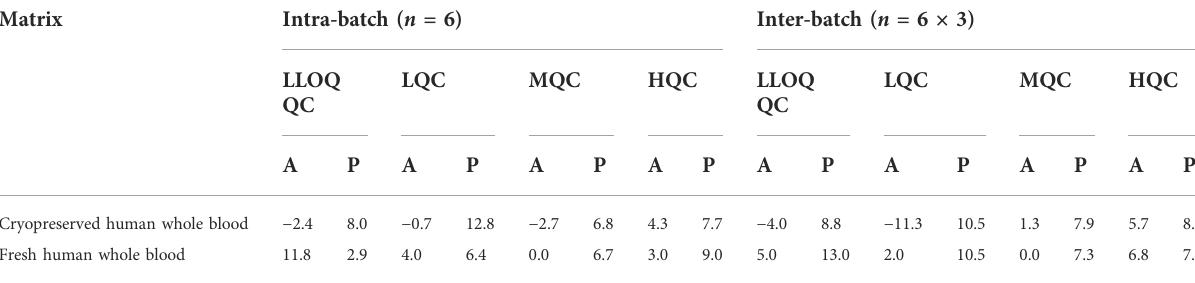
TABLE 3 Intra-batch and inter-batch precision and accuracy for SRL in cryopreserved and fresh human whole blood. Matrix